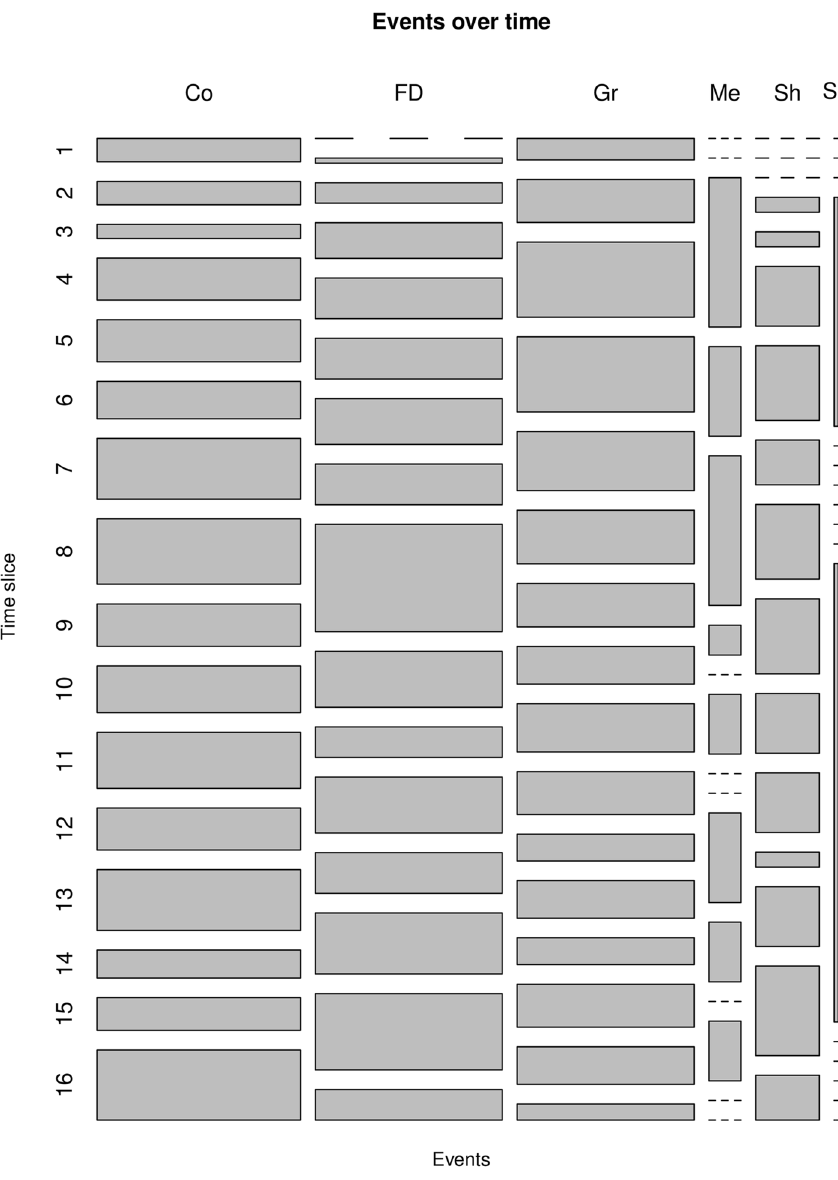
Figure 9. Events over time. Co continuing, FD forming or dissolving, Gr growing, Me merging, Sh shrinking, Sp splitting. For each column/event, the width of its rectangles corresponds to the frequency of this specific event over the whole time horizon. For each row/time slice, the height of a rectangle corresponds to the frequency of the event in the time slice when compered to the whole